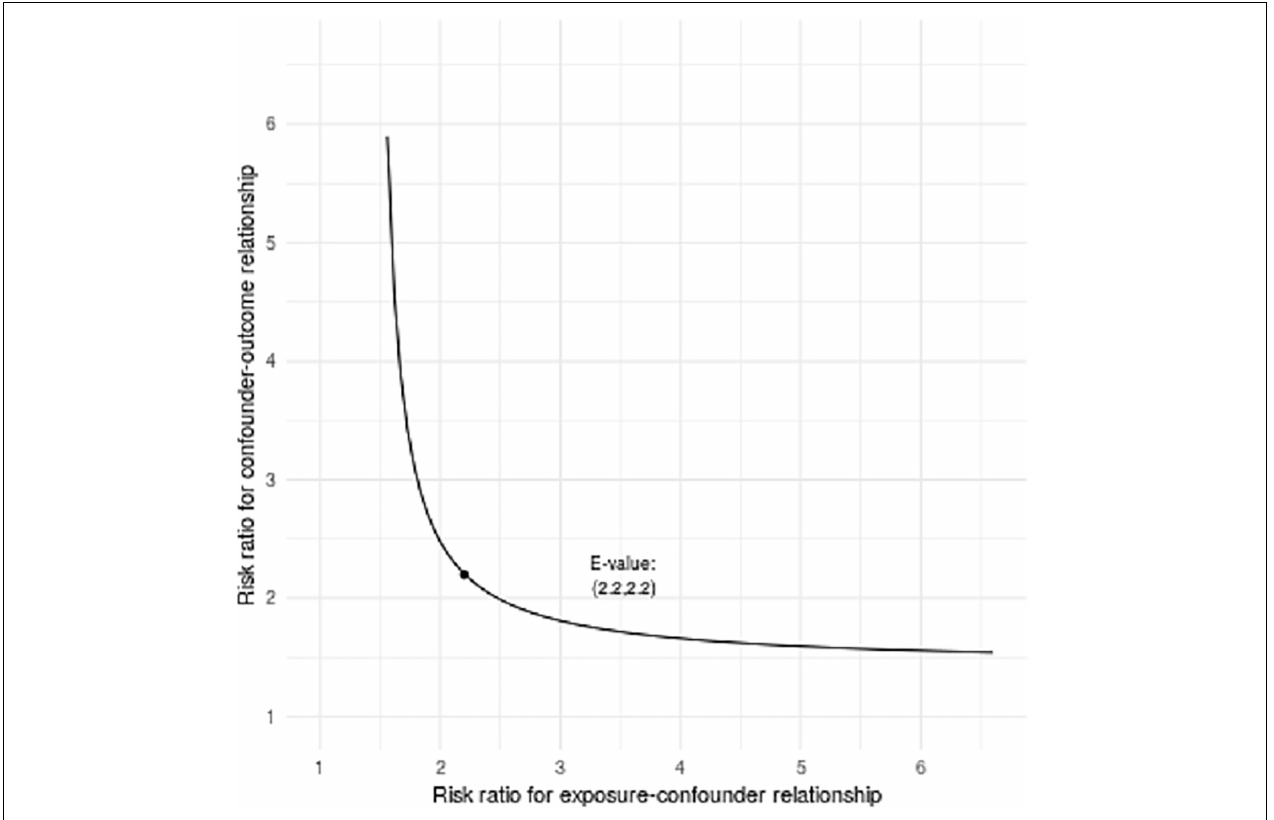
FIGURE 2 | Bias plots assessed by E -value analysis (outcome is any ICH). Bias plots represent varying levels of unobserved confounder/exposure association and unobserved confounder/outcome association necessary to render observed exposure/outcome association null for total cSVD score per point increase.